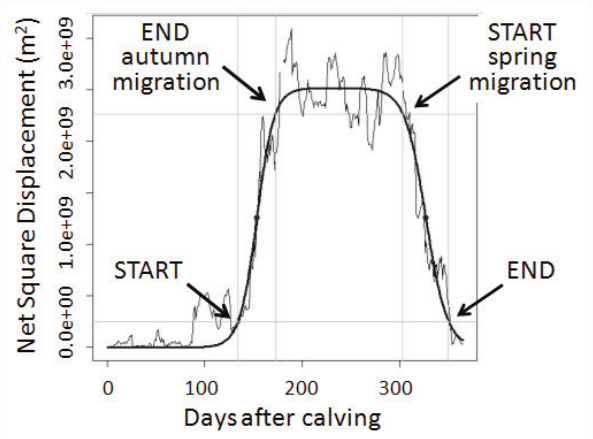
Fig. 2. Example of the migration parameters estimated for one focal individual based on its annual Net Square Displacement (NSD). The smooth line represents the (cid:80)(cid:82)(cid:71)(cid:72)(cid:79)(cid:3)(cid:191)(cid:87)(cid:87)(cid:72)(cid:71)(cid:3)(cid:87)(cid:82)(cid:3)(cid:87)(cid:75)(cid:72)(cid:3)(cid:73)(cid:82)(cid:70)(cid:68)(cid:79)(cid:3)(cid:76)(cid:81)(cid:71)(cid:76)(cid:89)(cid:76)(cid:71)(cid:88)(cid:68)(cid:79)(cid:3)(cid:87)(cid:82)(cid:3)(cid:71)(cid:72)(cid:86)(cid:70)(cid:85)(cid:76)(cid:69)(cid:72)(cid:3)(cid:76)(cid:87)(cid:86)(cid:3)(cid:80)(cid:76) - gratory movement from the calving range to the winter range and back (Bunnefeld et al., 2011). Grey lines iden- (cid:87)(cid:76)(cid:73)(cid:92)(cid:3)(cid:87)(cid:75)(cid:72)(cid:3)(cid:86)(cid:87)(cid:68)(cid:85)(cid:87)(cid:3)(cid:68)(cid:81)(cid:71)(cid:3)(cid:72)(cid:81)(cid:71)(cid:3)(cid:82)(cid:73)(cid:3)(cid:80)(cid:76)(cid:74)(cid:85)(cid:68)(cid:87)(cid:76)(cid:82)(cid:81)(cid:15)(cid:3)(cid:71)(cid:72)(cid:191)(cid:81)(cid:72)(cid:71)(cid:3)(cid:68)(cid:86)(cid:3)(cid:24)(cid:8)(cid:3)(cid:68)(cid:81)(cid:71)(cid:3) 95% of the sigmoid.